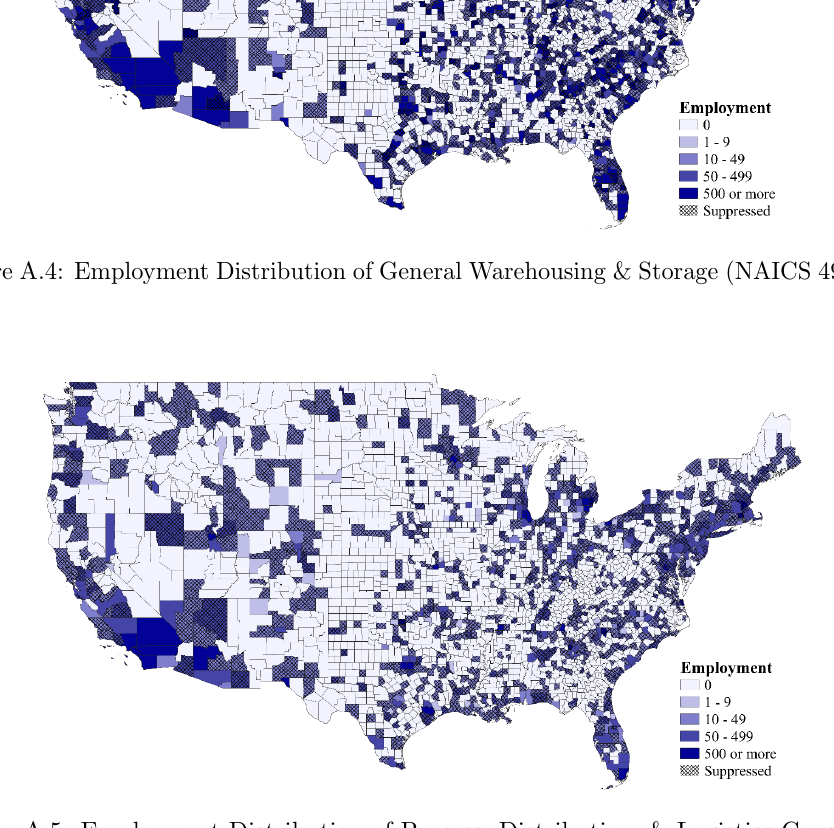
REGION : Volume 9, Number 1,